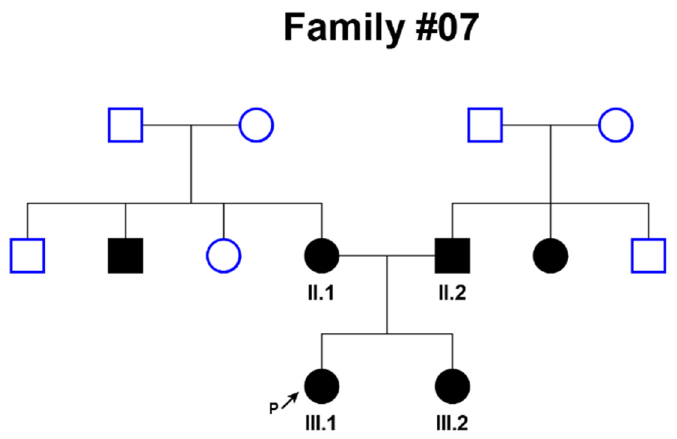
Figure 1. Pedigree of family #07 affected by hereditary nonsyndromic sensorineural hearing loss. P indicates proband.